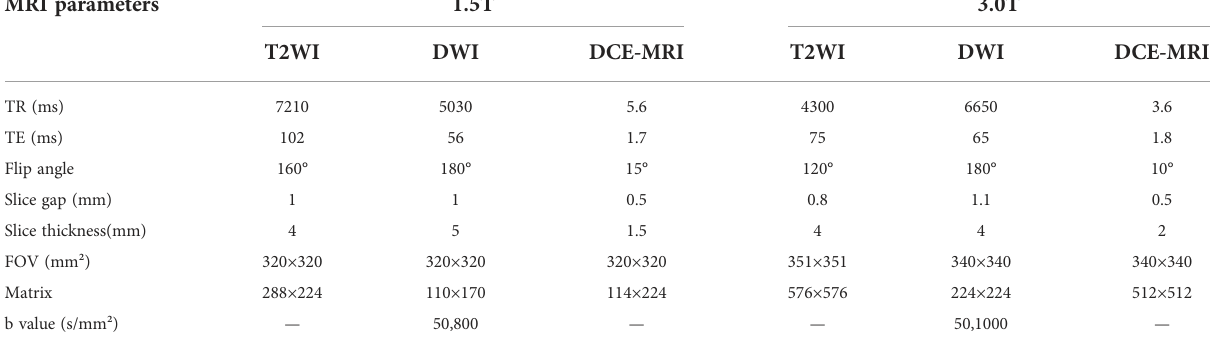
TABLE 2 Magnetic Resonance Imaging Scanner Parameters.